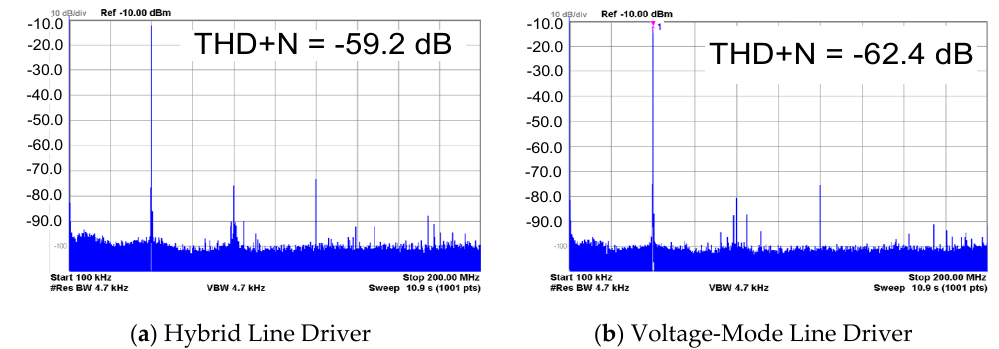
Figure 12. Measured THD+N of the proposed hybrid line driver, and the conventional voltage-mode line driver at F IN = 40 MHz and 930 mV PP differential of signal swing on the bus lines.